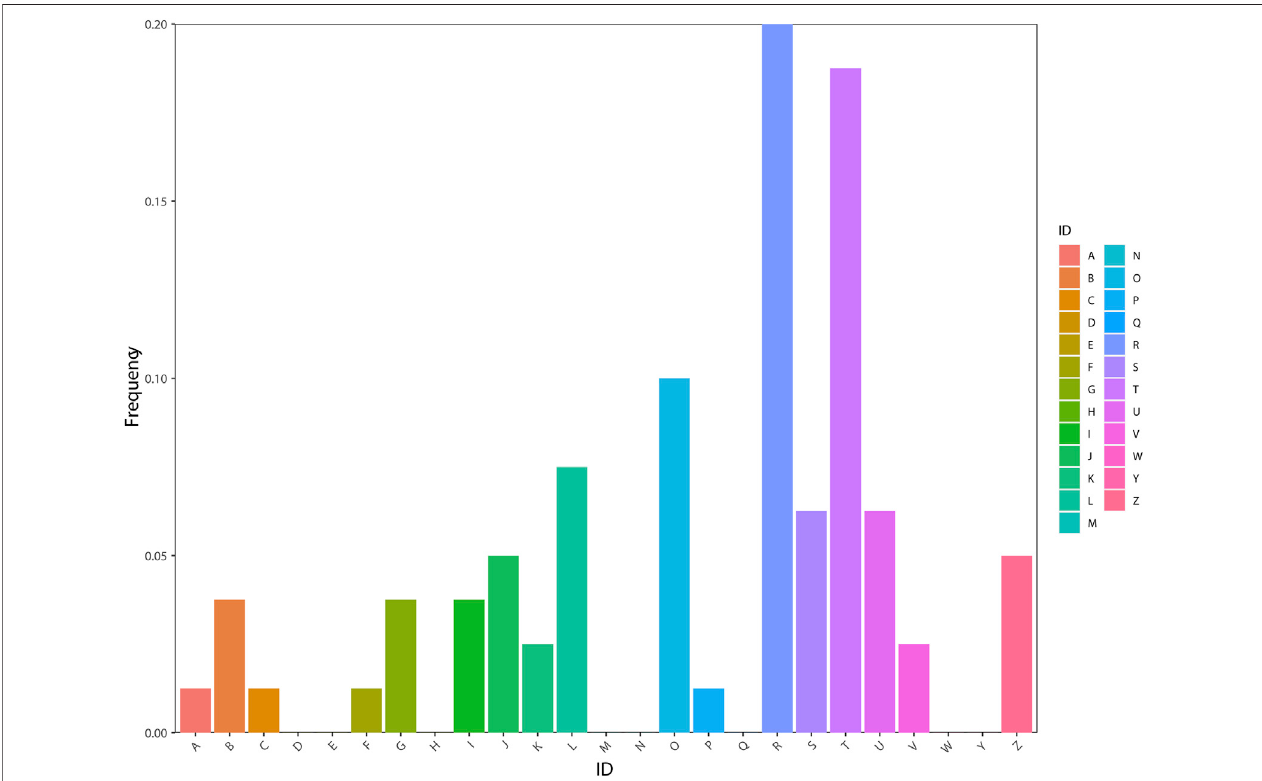
FIGURE4| Functionalclassi fi cationofgenesusingtheKOGdatabase. (A) RNAprocessingandmodi fi cation[1-1.25%]; (B) Chromatinstructureanddynamics[3- 3.75%]; (C) Energy production and conversion [1-1.25%]; (D) Cell cycle control, cell division, and chromosome partitioning [0-0%]; (E) Amino acid transport and metabolism [0-0%]; (F) Nucleotide transport and metabolism [1-1.25%]; (G) Carbohydrate transport and metabolism [3-3.75%]; (H) Coenzyme transport and metabolism [0-0%]; (I) Lipid transport and metabolism [3-3.75%]; (J) Translation, ribosomal structure, and biogenesis [4-5%]; (K) Transcription [2-2.5%]; (L) Replication,recombination,andrepair[6-7.5%]; (M) Cellwall/membrane/envelopebiogenesis[0-0%]; (N) Cellmotility[0-0%]; (O) Posttranslationalmodi fi cation,protein turnover,andchaperones[8-10%]; (P) Inorganiciontransportandmetabolism[1-1.25%]; (Q) Secondarymetabolitebiosynthesis,transport,andcatabolism[0-0%];